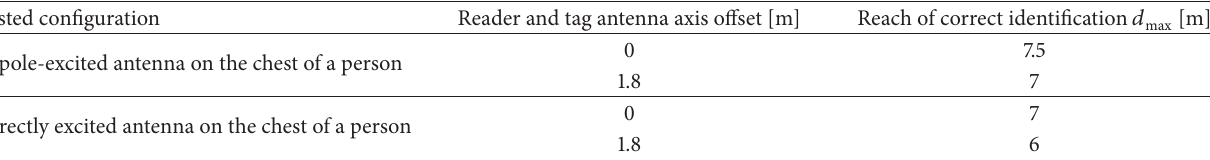
Table 2: Measured maximum identification distance in the corridor of building 4m in width and 3.5 m in